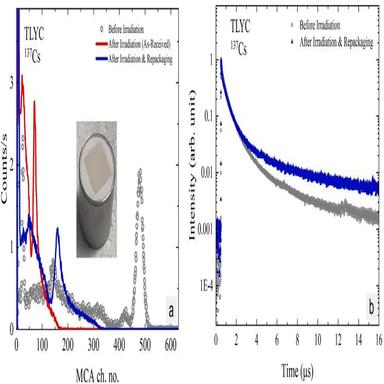
Before and after radiation hardness test measurements at Fisk on the 17 × 17 × 25 mm3 hermetically encapsulated TLYC crystal (a) 137Cs spectra collected by the encapsulated TLYC crystal: before irradiation, as received after irradiation, and after repackaging. Inset picture: the encapsulated TLYC crystal prior to shipment to Penn State. (b) Temporal data collected by the TLYC crystal before irradiation and after irradiation & repackaging.